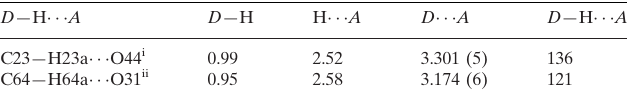
Hydrogen-bond geometry (A˚ , (cid:3)